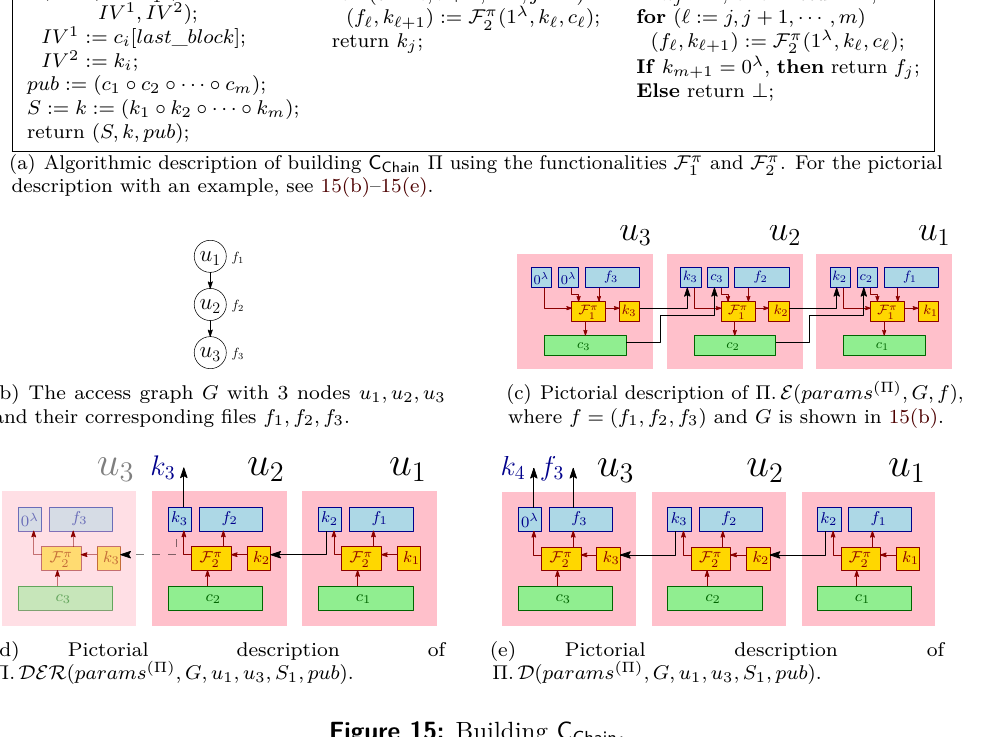
Figure 15: Building C Chain